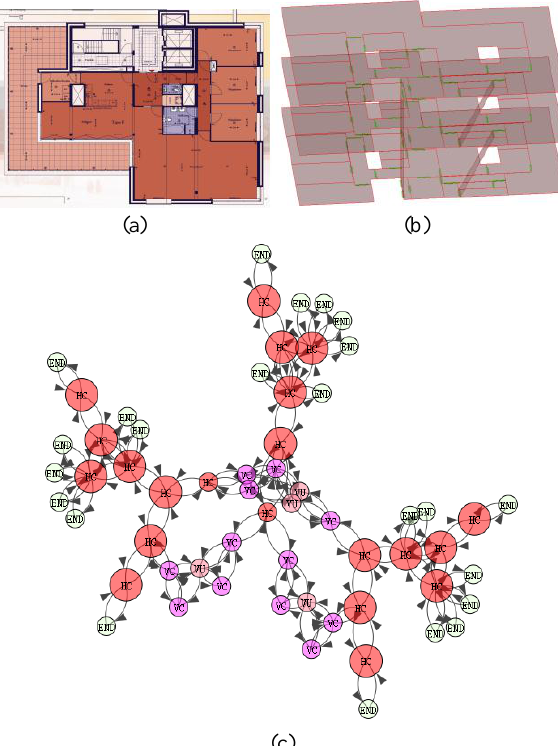
Figure 6. Vermeer building (a) original floor plans; (b) recreated